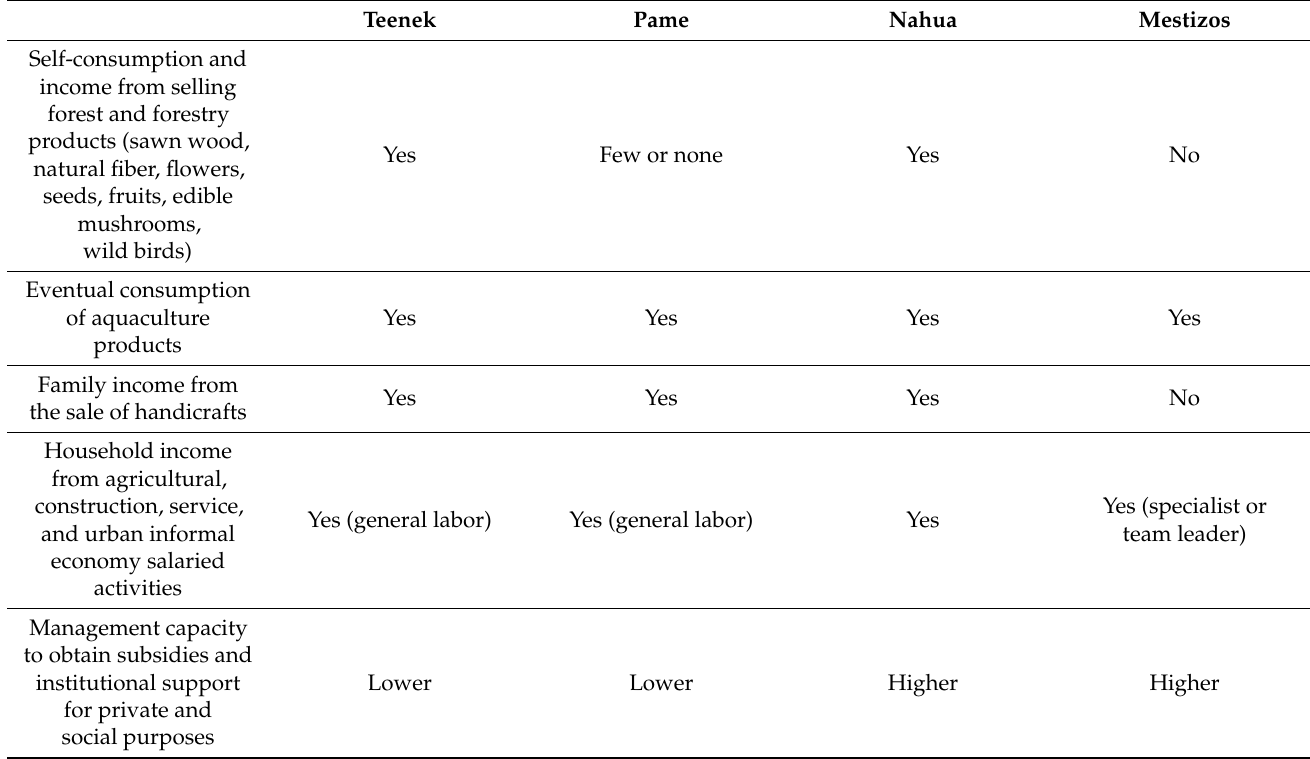
Table A1. Cont. Teenek Pame Nahua